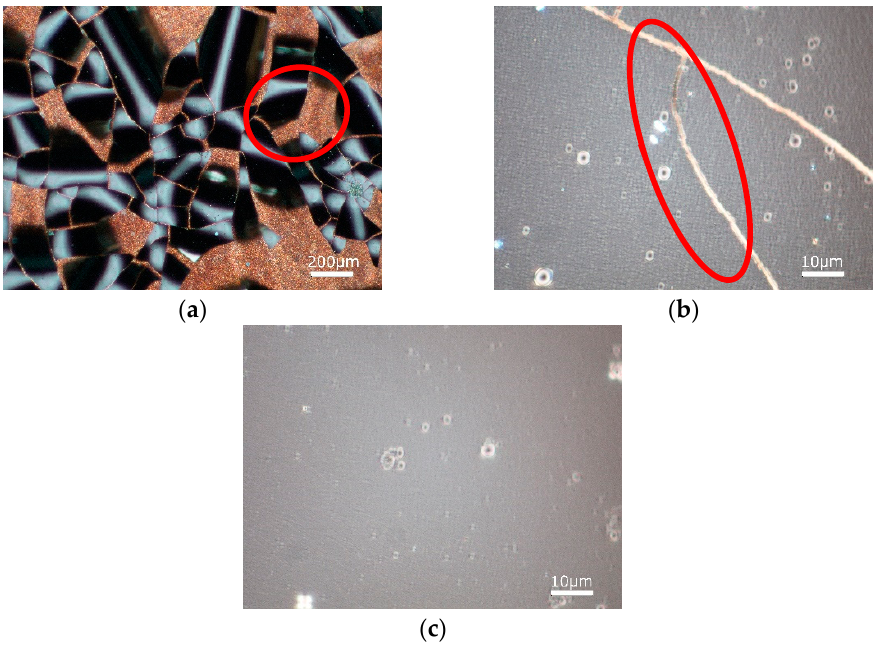
Figure 6. OM images of sample ( a ) #6C; ( b ) #8C and ( c ) #10C are shown in the figures. For samples #6C and #8C the presence of cracks can be observed (e.g., the features highlighted by the red circles) while for sample #10C the surface results were smooth and free of defects.